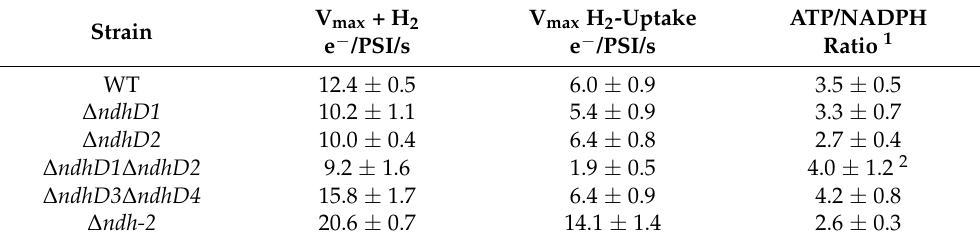
Table 1. ATP/NADPH ratio as calculated from electron flow through PSI (V max + H 2 ) and electrons generated by H 2 oxidation (V max H 2 -uptake). If an electron is introduced into the intersystem chain by the NDH-1 complex it should translocate 4 H + into the lumen before passing PSI. In Synechocystis 4.66 H + are needed to produce one ATP resulting in the production of 10.6 ATP from 12.4 electrons. On the other hand, when H 2 is the only electron donor, two electrons from H 2 oxidation should yield one NADPH. In wild type cells three NADPH are formed from six e − and an ATP/NADPH ratio of 10.6/3 = 3.5 is produced. Standard deviations are given. V max + H 2 Strain e −